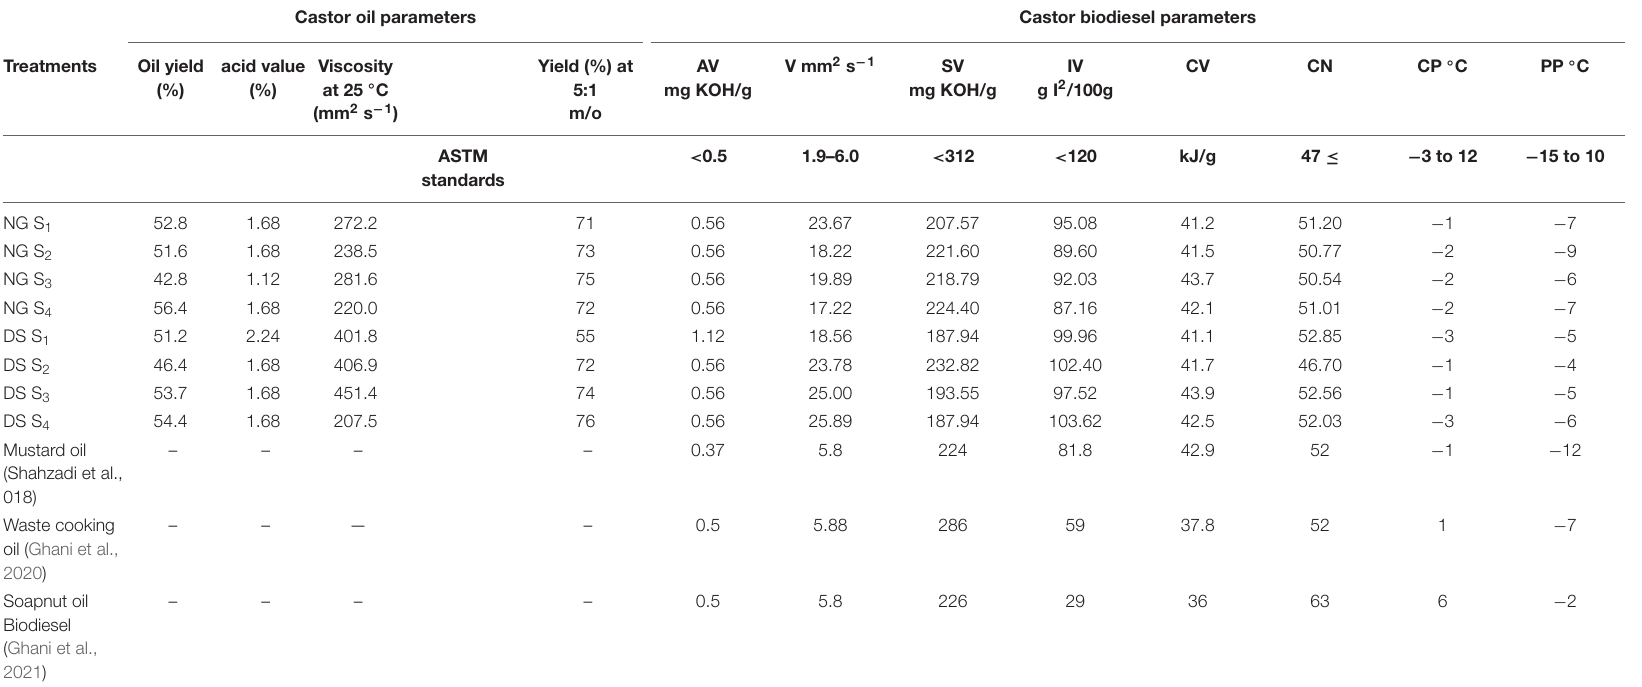
TABLE 7 | Effect of sulfur and cultivar on oil and biodiesel quality parameters of castor bean. Castor oil parameters Castor biodiesel